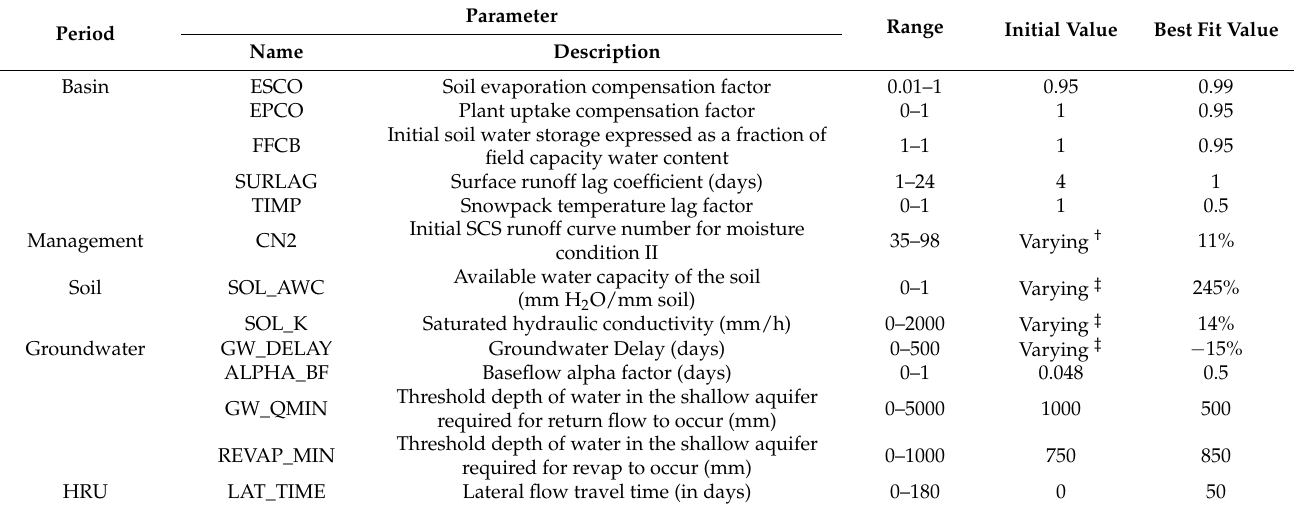
Table 5. Change in average yearly temperature in ◦ C. The periods used were 2021–2040, 2041–2060, 2061–2080, and